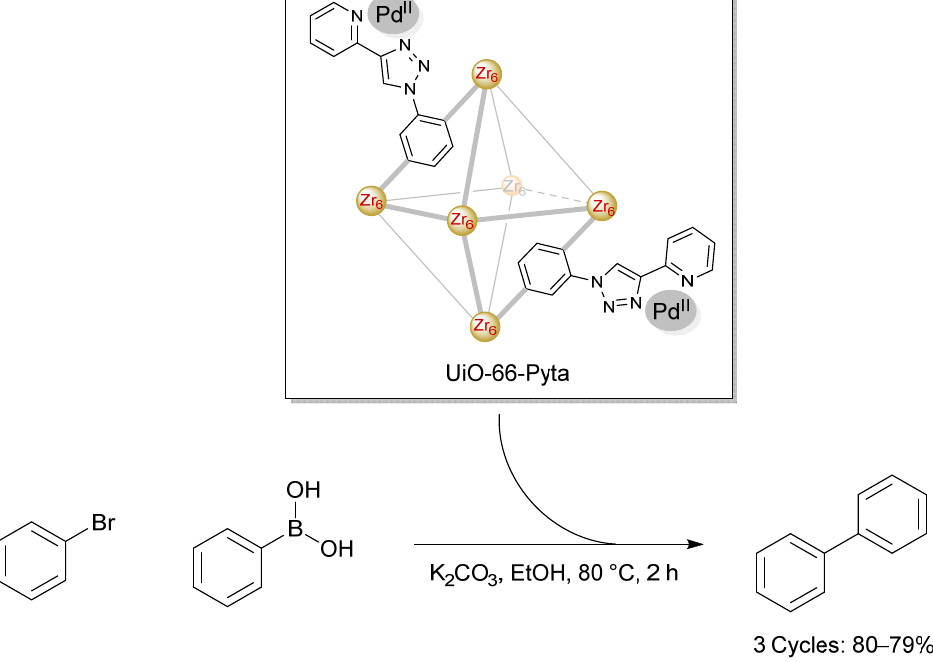
Figure 8. Palladium ‐ loaded UiO ‐ 55 ‐ Pyta MOF employed as a Suzuki–Miyaura catalyst [97]. Figure 8. Palladium-loaded UiO-55-Pyta MOF employed as a Suzuki–Miyaura catalyst